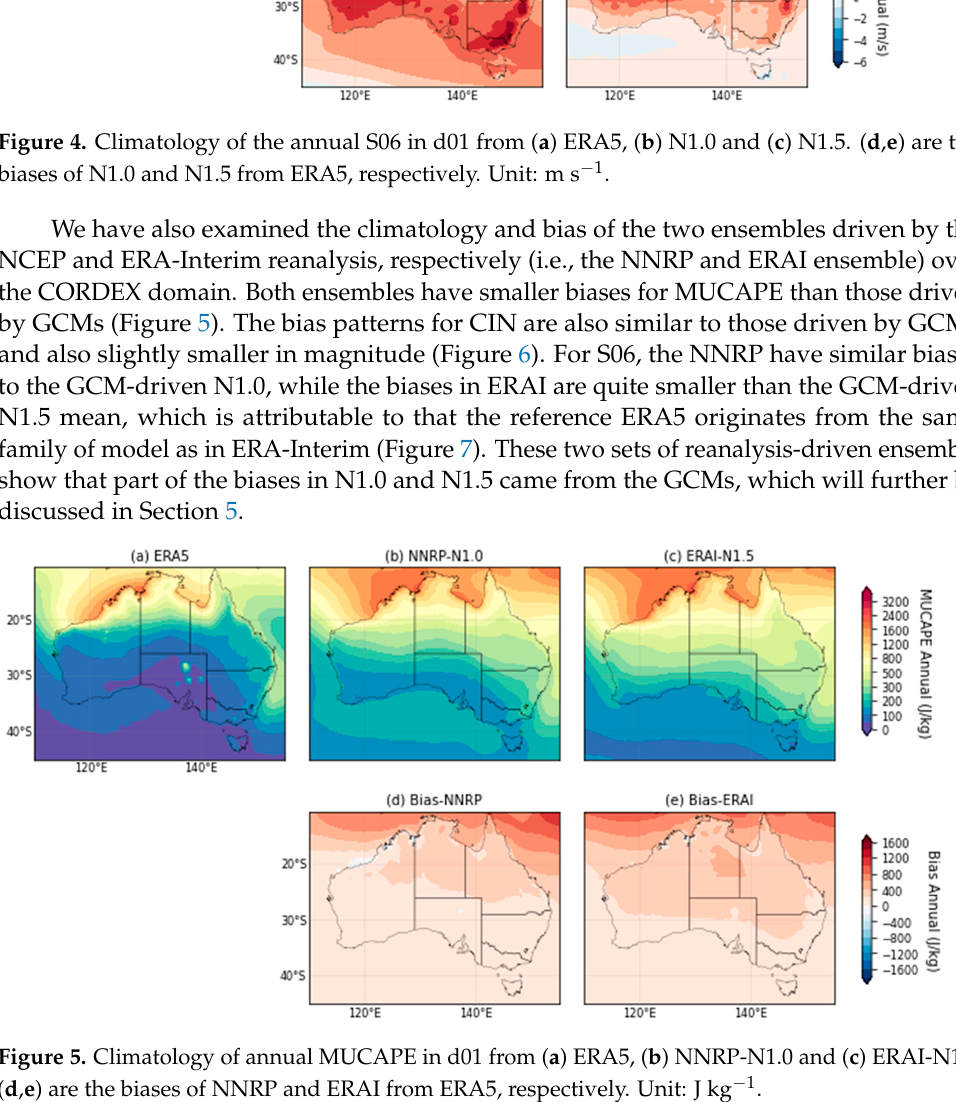
Figure 4. Climatology of the annual S06 in d01 from ( a ) ERA5, ( b ) N1.0 and ( c ) N1.5. ( d , e ) are the biases of N1.0 and N1.5 from ERA5, respectively. Unit: m s − 1 .